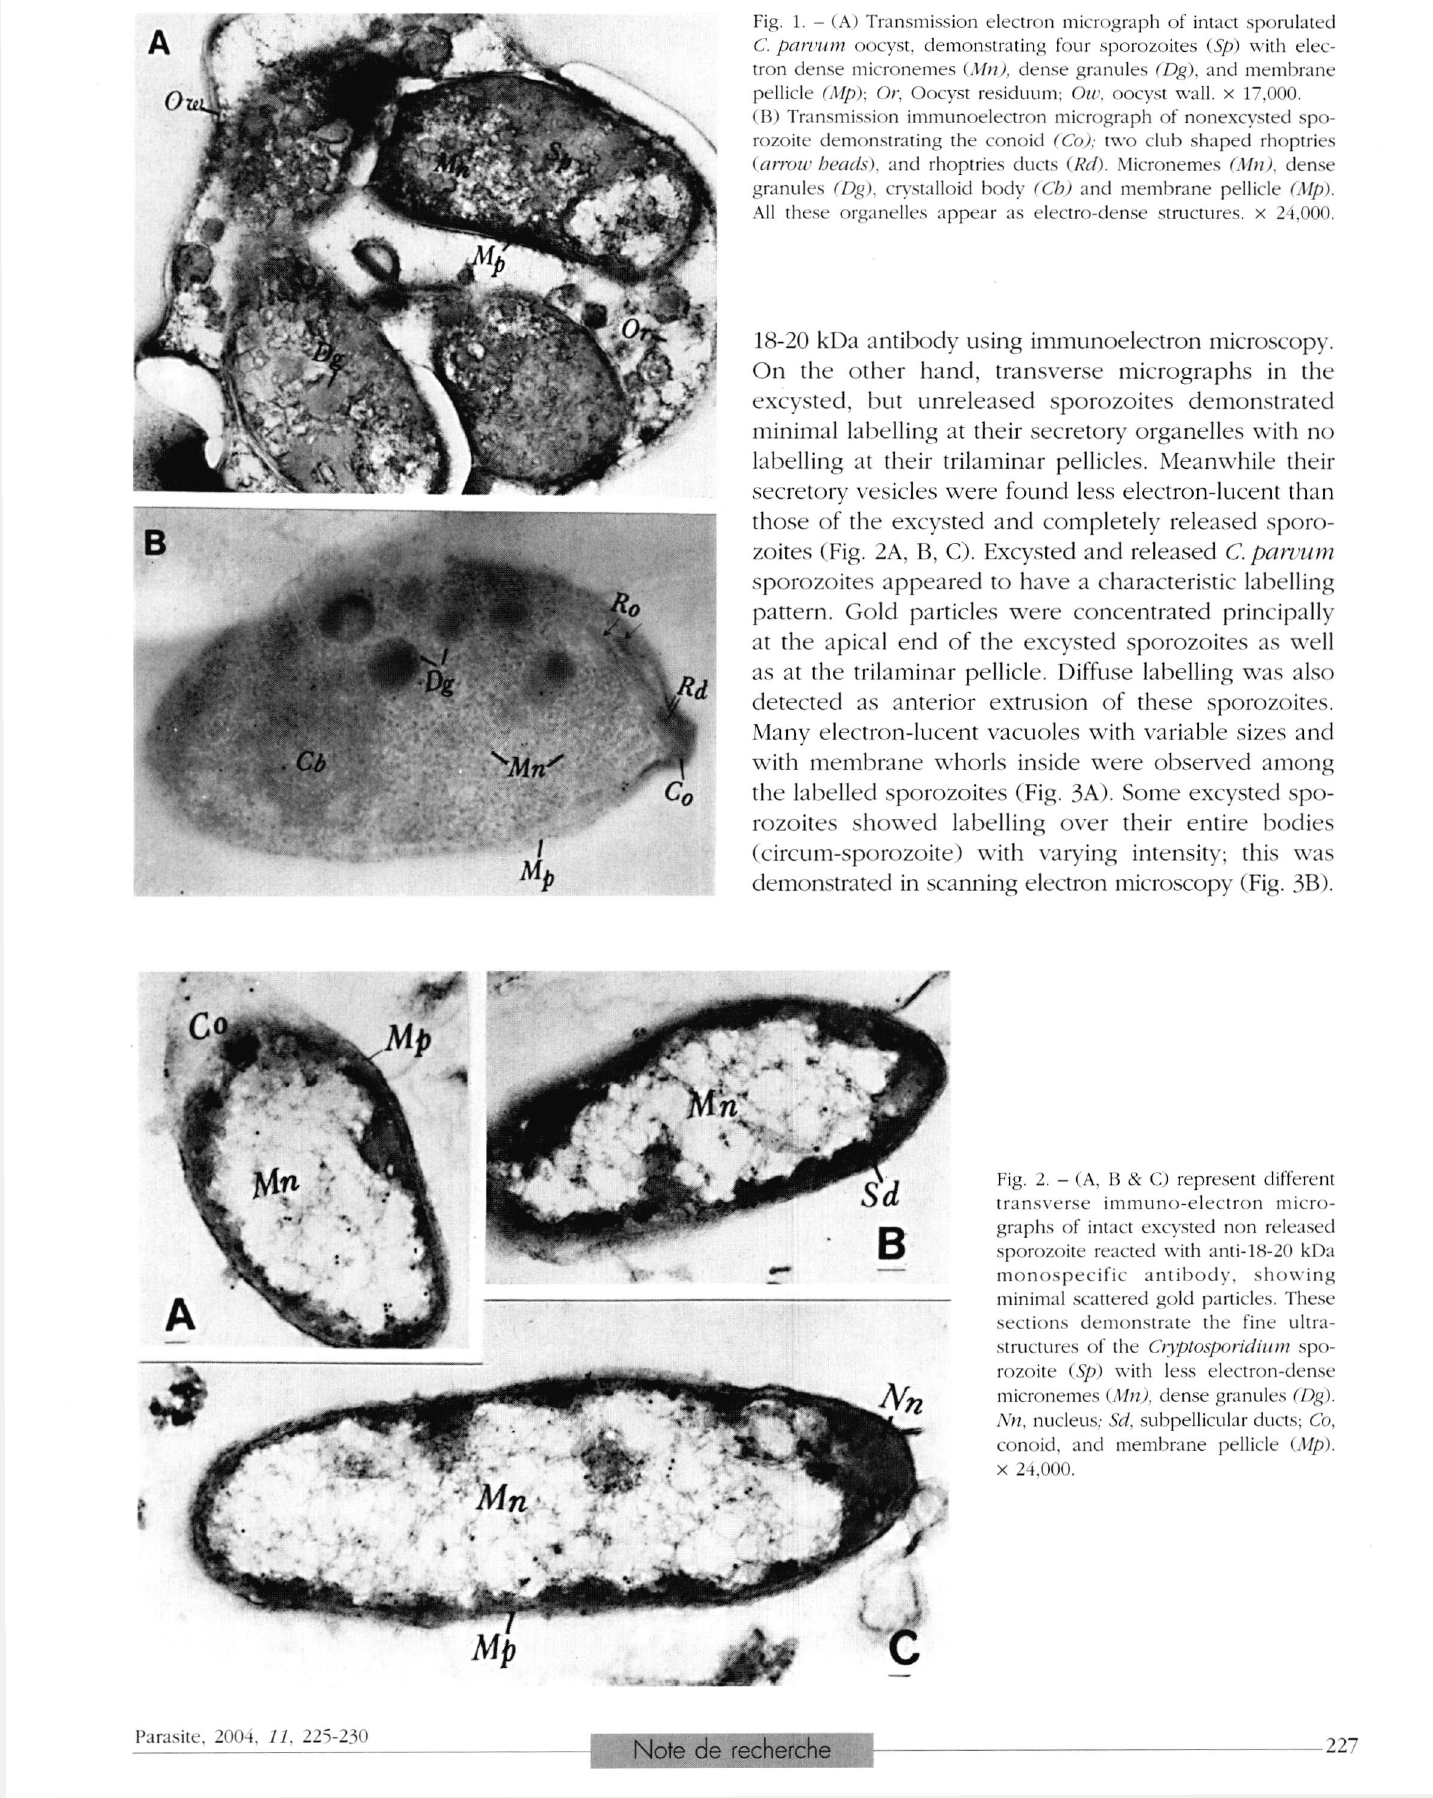
Fig. 1. - (A) Transmission electron micrograph of intact sporulated C. parvum oocyst, demonstrating four sporozoites (Sp) with elec tron dense micronemes (Mn), dense granules (Dg), and membrane pellicle (Mp); Or, Oocyst residuum; Ow, oocyst wall, x 17.000.